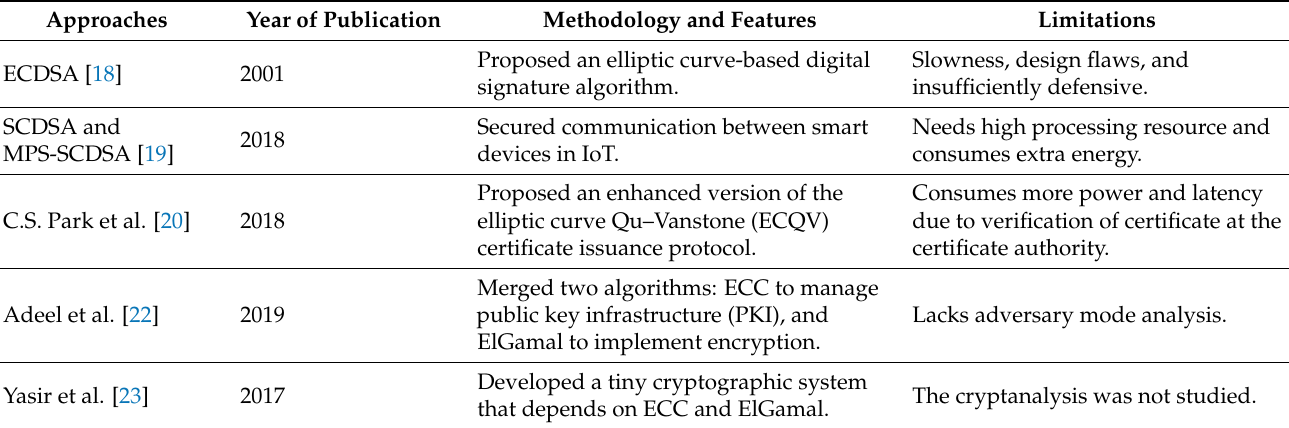
Table 2. Summary of related